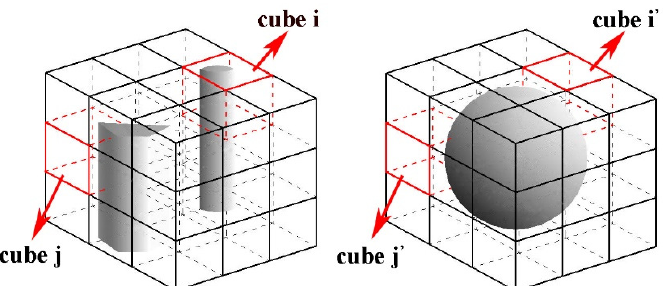
Figure 5. Schematic diagram of the spatial grid division of the NVCI. The left picture is the spatial grid division for the buildings, and the right picture is for the equivalent sphere.